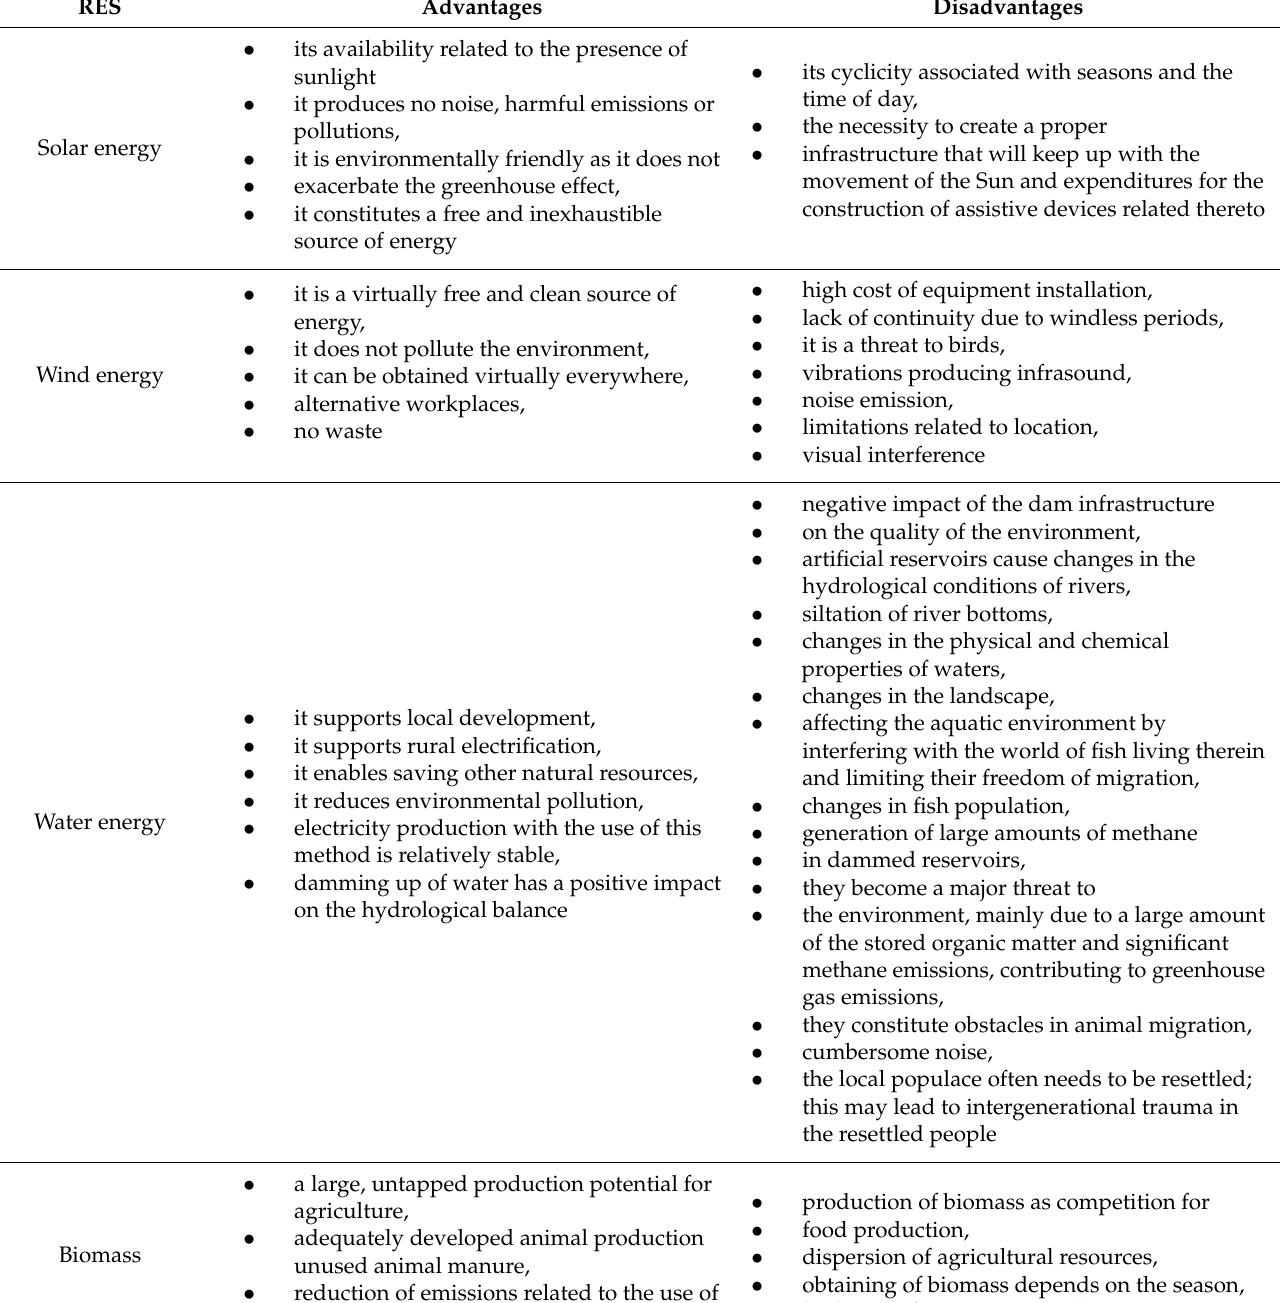
Table 2. Advantages and disadvantages of the impact of renewable energy sources.